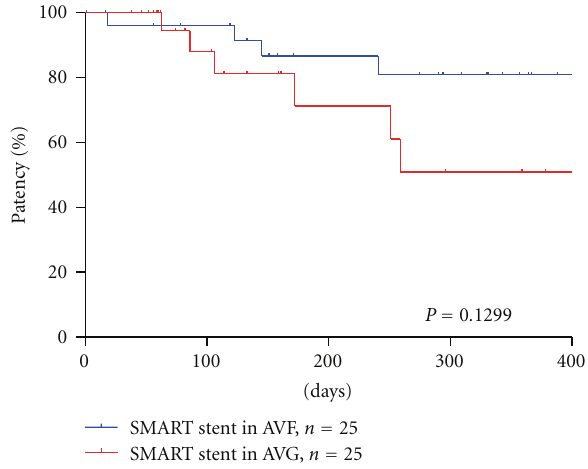
Figure 2: Secondary patency rates of SMART stent placement in AVF and AVG. There was no significant di ff erence in the secondary patency rates between AVF and AVG, but patency in AVG showed inferior to